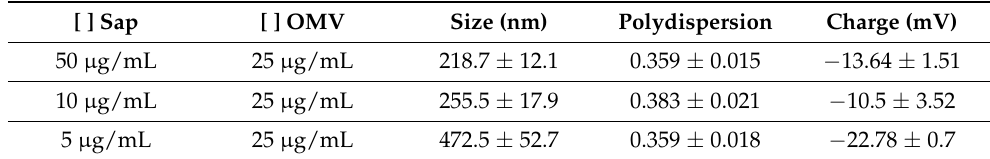
Table 3. Physical properties of Sap complexed to N. meningitidis